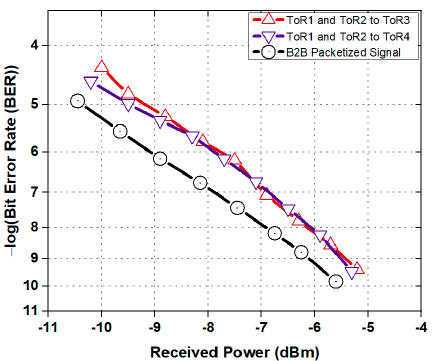
Figure 10. BER curves for the 50 Gb/s packet switch transmission.